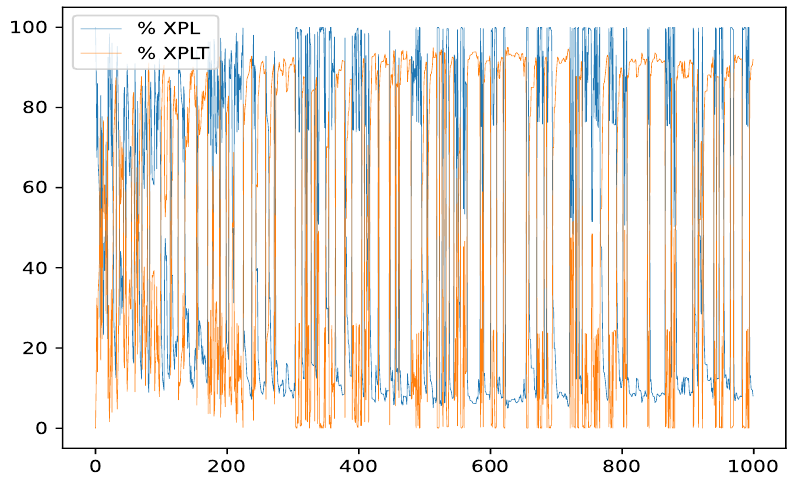
Figure 19. GWO-QL5-b5 Dimensional Hussain.